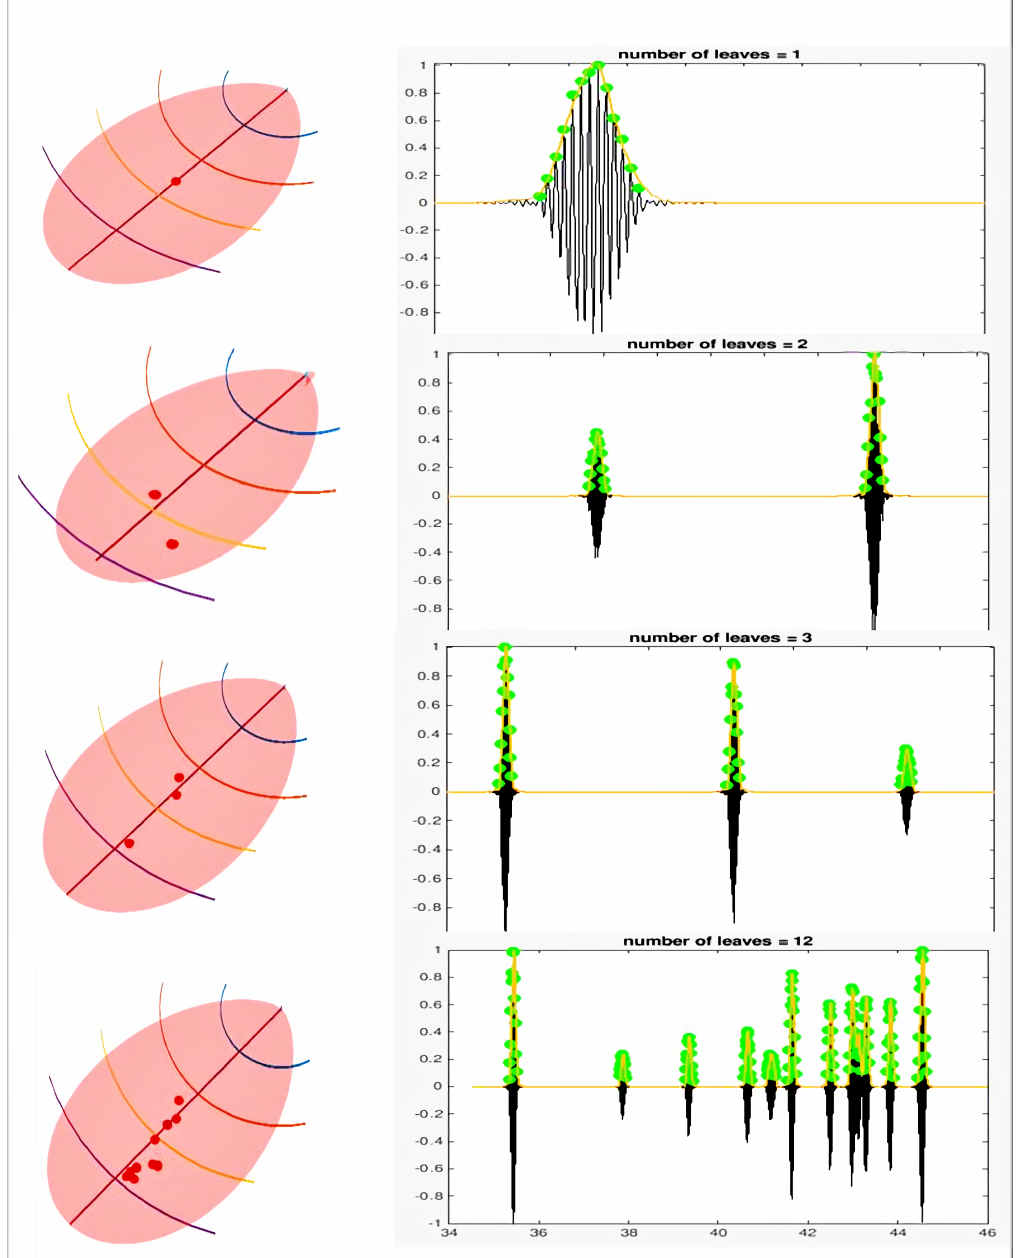
Figure 2. The main lobe was divided into five equally spaced segments using hyperplanes. The leaf position can be seen on the left side. The right side of the plots shows the recorded echo peaks and their time spans. Here, the X -axis denotes the time span and the Y -axis denotes the amplitude of the recorded